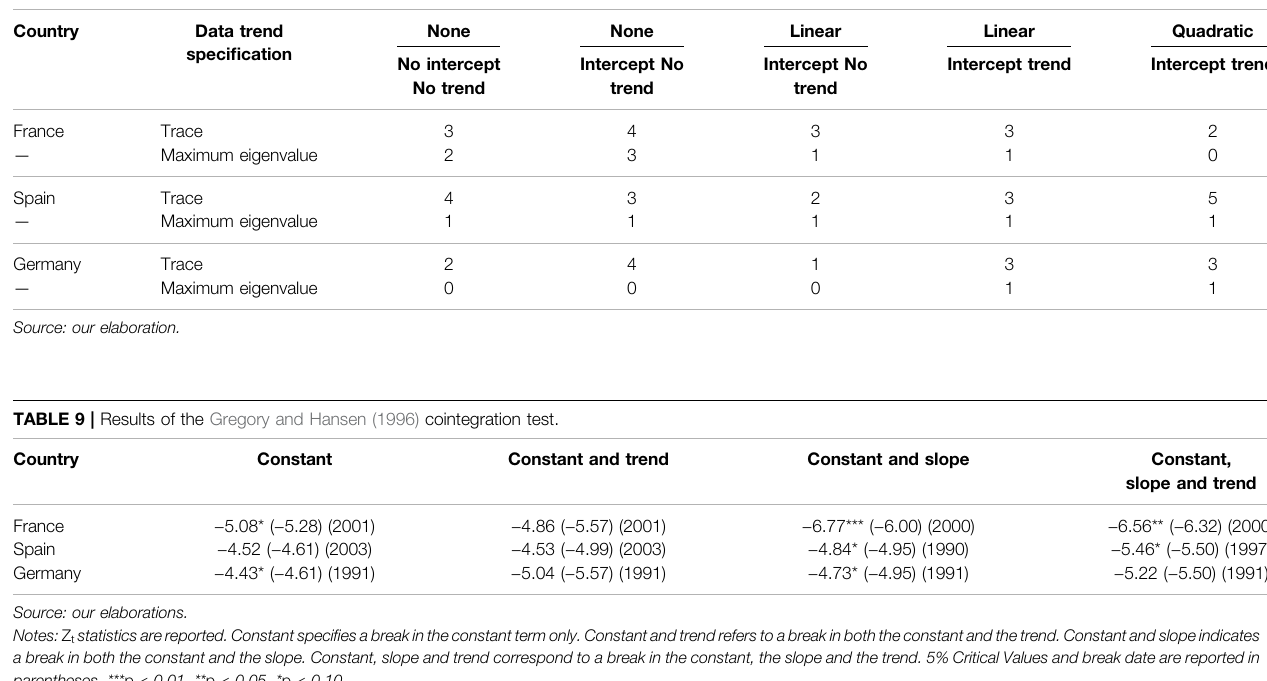
TABLE 8 | Results of the Johansen and Juselius (1990) test for cointegration. Country Data trend None None Linear Linear Quadratic speci fi cation No intercept Intercept No Intercept No Intercept trend Intercept trend No trend trend trend